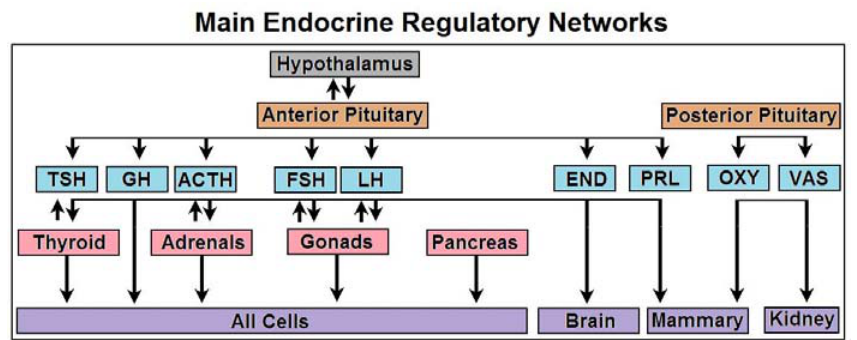
Figure 12. Main Endocrine Regulatory